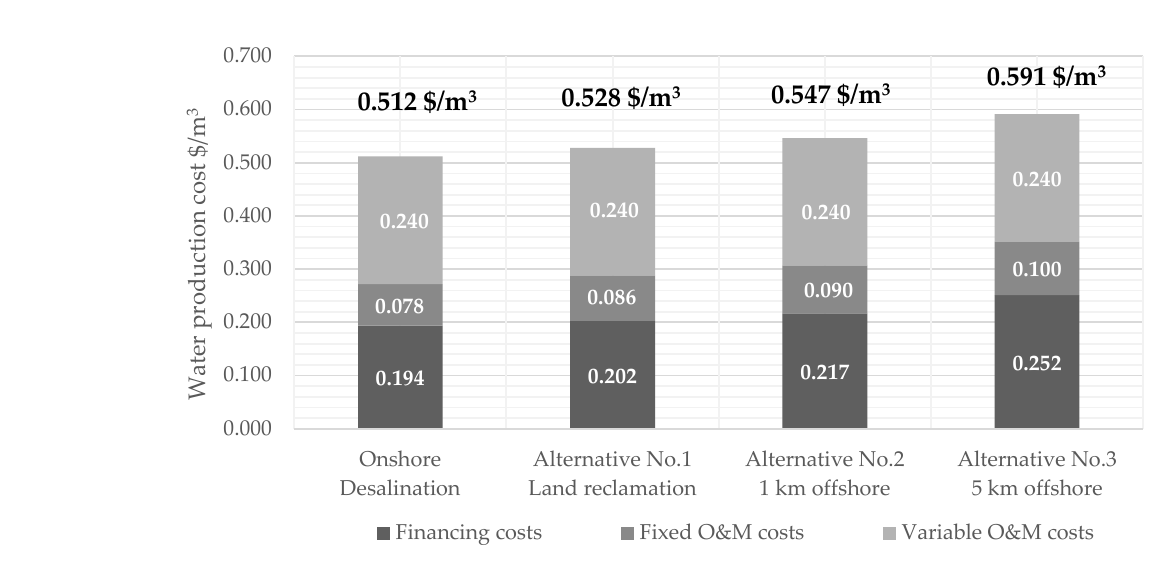
Figure 6. Comparison of the specific water production cost for all alternatives.